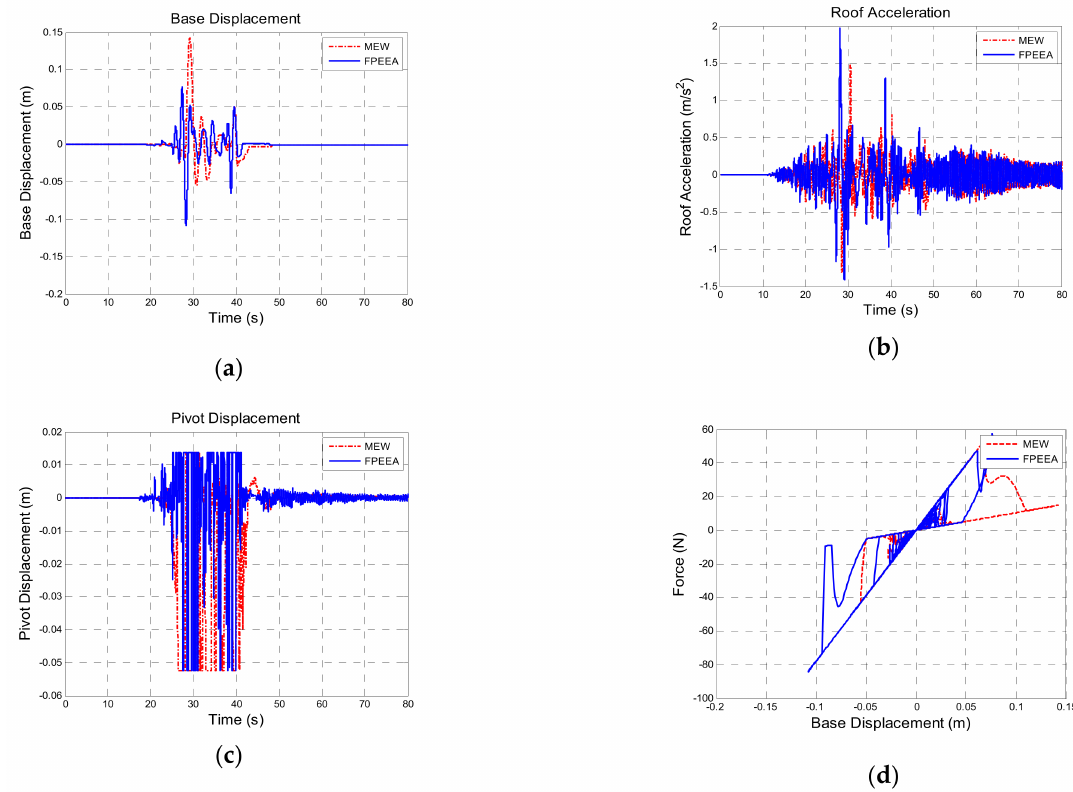
Figure 13. Comparison for the FPEEA and MEW controls (TCU102, PGA = 0.1 g). ( a ) Isolation layer displacement. ( b ) Superstructure acceleration. ( c ) Pivot displacement. ( d ) Hysteresis